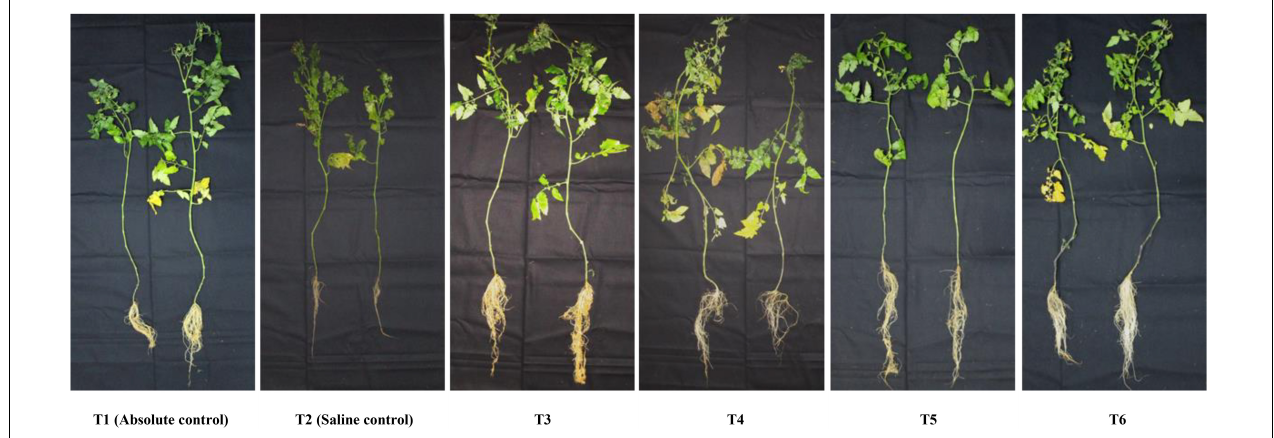
FIGURE 2 | Phenotypic observation of the plants under different treatments indicating improvement in root and shoot growth and biomass accumulation. T1, absolute control; T2, saline control; T3, BTL5; T4, GTR8; T5, GTR11; and T6, GTS16.